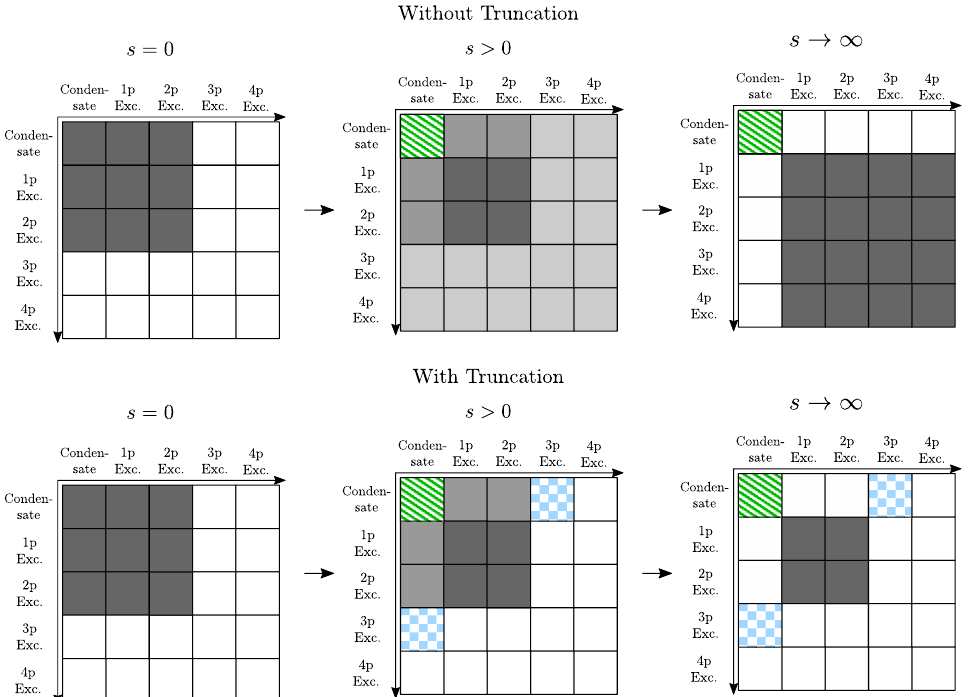
Figure 1: Illustration of the action of the flow equation (1) on the Hamiltonian. The Hamiltonian matrix is unitarily transformed to a block-diagonal form, such that the ground state (hatched green) becomes decoupled. The upper row illustrates the exact transformation without a truncation. Note that many-body excitations appear during the flow. The bottom row illustrates a truncation scheme adopted to circumvent this problem. The induced three-body terms (checkered blue) can be estimated and used to evaluate the accuracy of the truncation scheme. The excitations are defined with respect to the adopted normal ordering, see Sec.